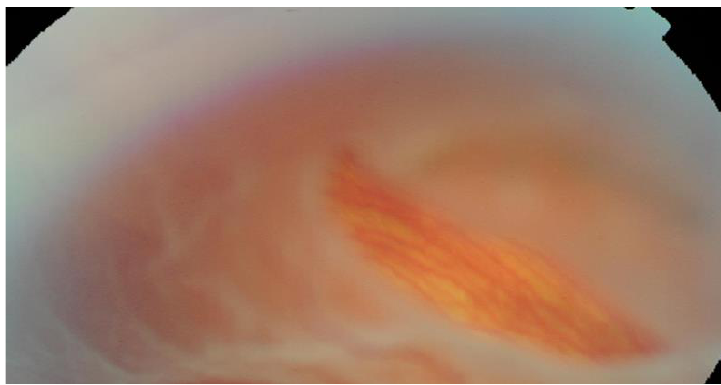
Figure 2. Horseshoe retinal tear